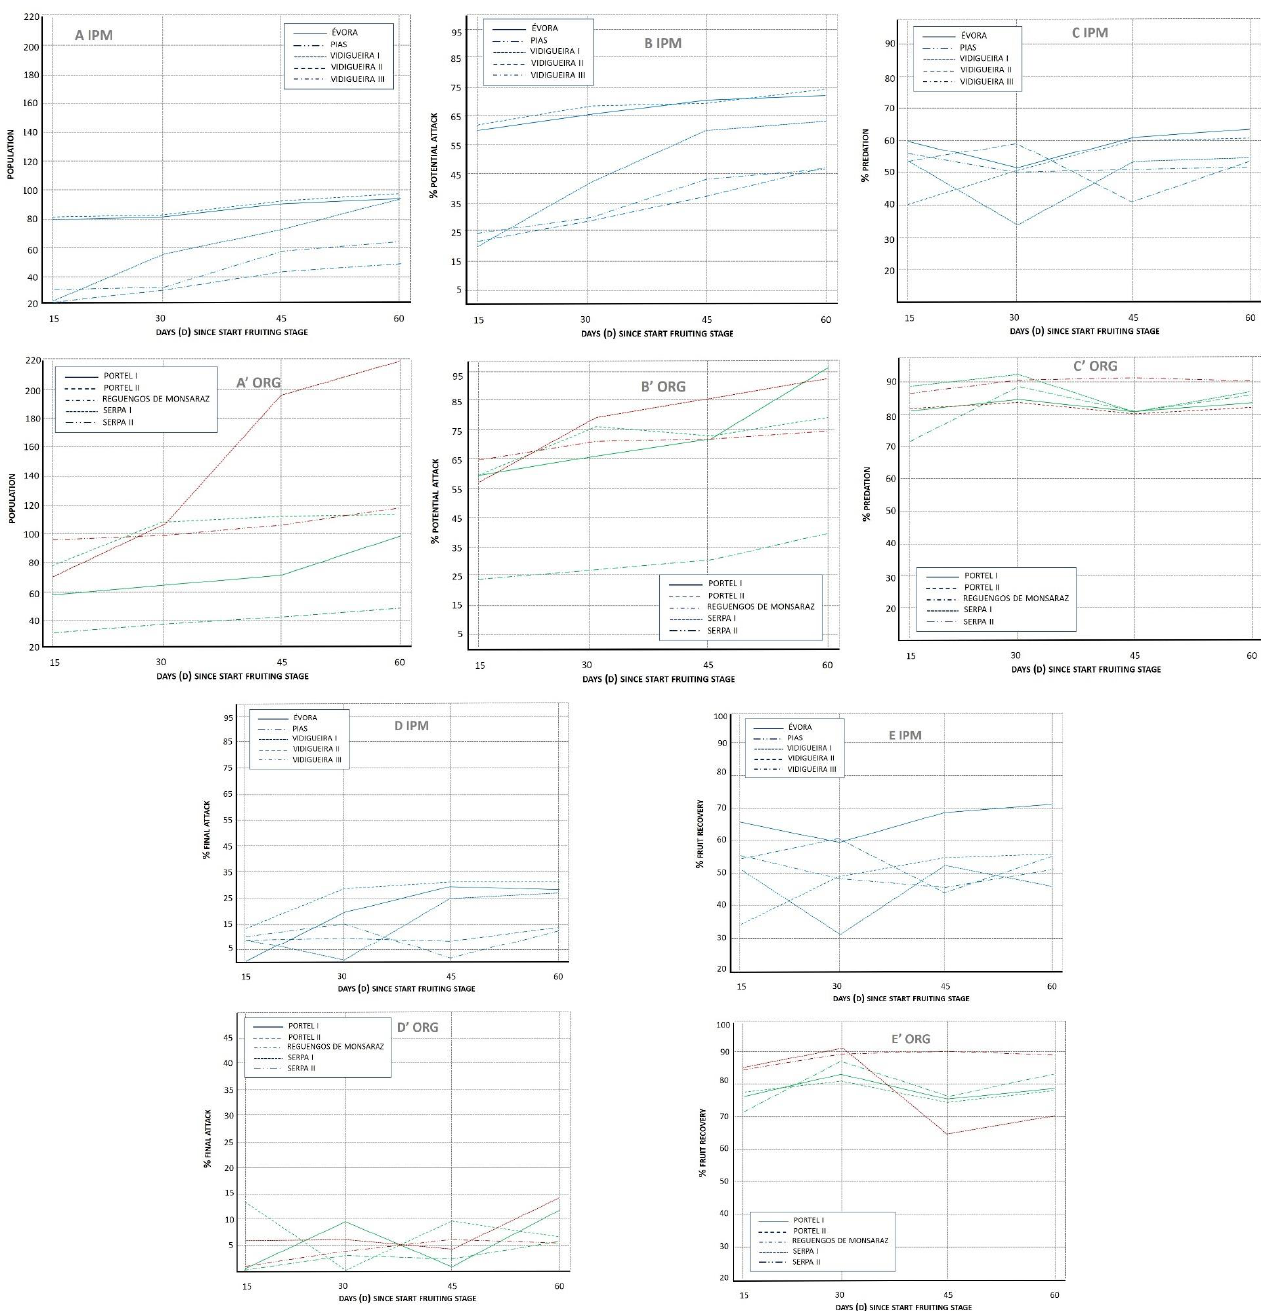
Figure 3. Parameters of P. oleae attack in olive groves under different agronomic management models: IPM (Graphs A – D ) and organic (Graphs A ’ – D’ ) selected in southern Portugal. Population index (POP, Graphs A , A’ ). Potential Attack (%PA, Graphs B , B’ ); Predation (%PRED, Graphs C , C’ ); Final Attack (%FA, Graphs D , D’ ); % Recovery (%REC, Graphs E , E’ ). Among the organic olive groves, the olive groves corresponding to organic – biodynamic management are marked with red lines.